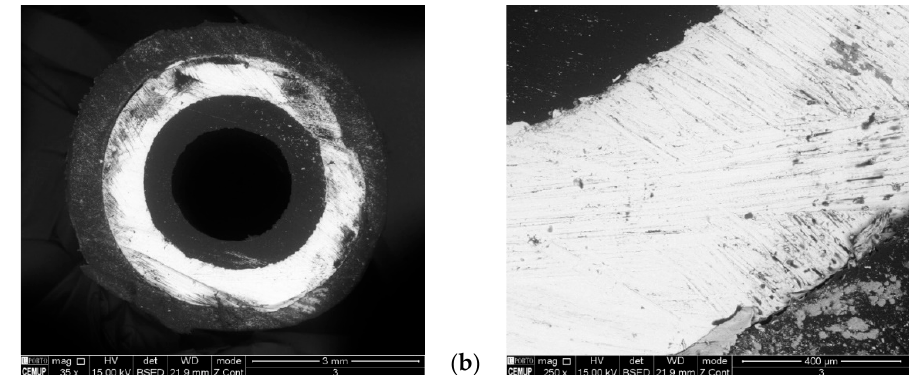
Figure 12. Microscopic images for the laminated spiral with abrasive disk cut: magnification of 40× ( a ) and 250× ( b ).